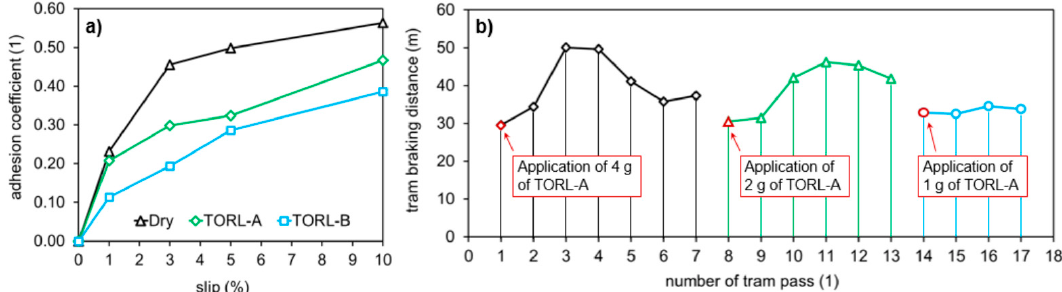
Figure 1. Adhesion curves for dry and lubricated conditions ( a ) and the effect of TOR lubricant quantity on tram braking distance ( b